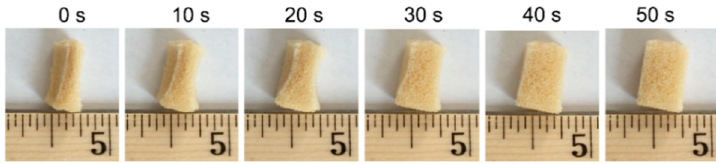
Figure 3. Progression of the shape recovery process of the compressed porous SMP foam in response to direct heating above the SMP’s T g .